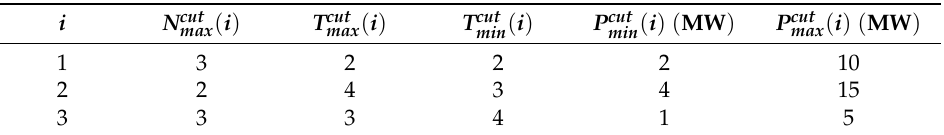
Table 1. Contract data of curtailable loads.